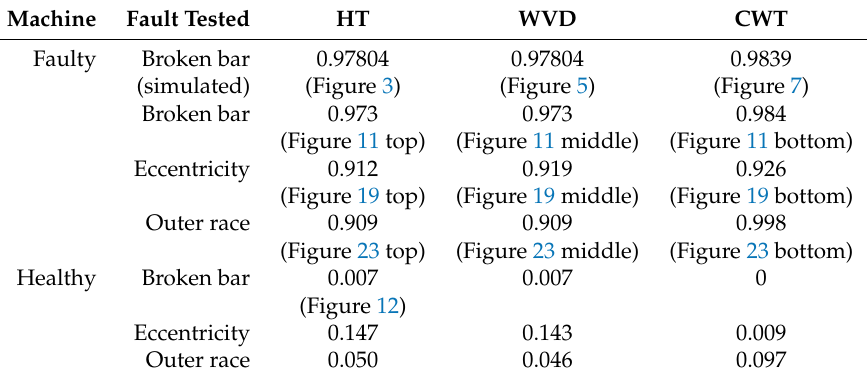
Table 1. Comparison of the values of the correlation parameter R IF computed with three different methods (HT, WVD, and CWT)